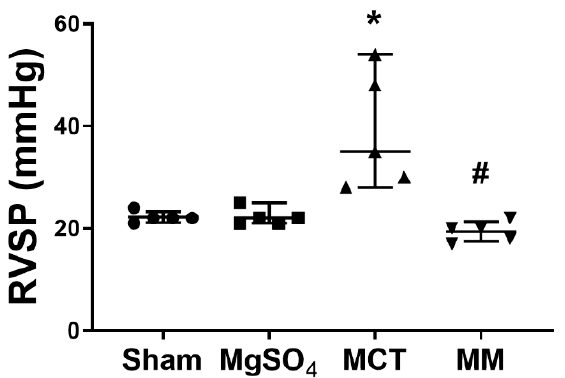
Figure 1. Magnesium sulfate (MgSO 4 ) mitigates monocrotaline-induced increases in right ventricular systolic pressure (RVSP) in rats. MgOS 4 : MgSO 4 (100 mg / kg / day) group. MCT: monocrotaline (60 mg / kg) group. MM: monocrotaline (60 mg / kg) plus MgSO 4 (100 mg / kg / day) group. Data are expressed as median (range). RVSP data were obtained from five rats from each group. * p < 0.05 versus the sham group. # p < 0.05 versus the MCT group.